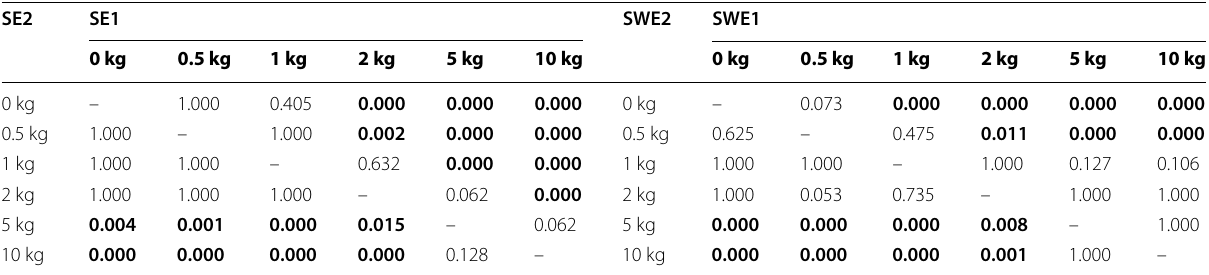
Table 2 Friedman test p values between the different contraction levels for the different technologies